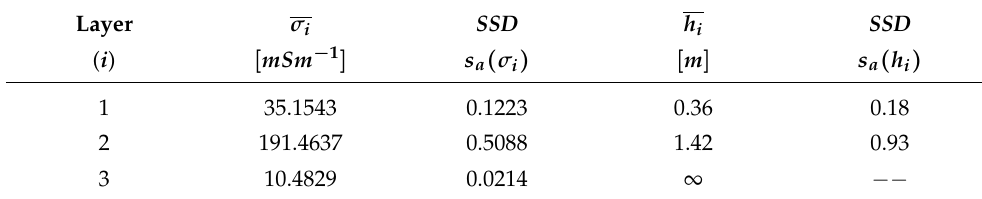
Table 6. Mean values and sample standard deviations of 3D mapping of